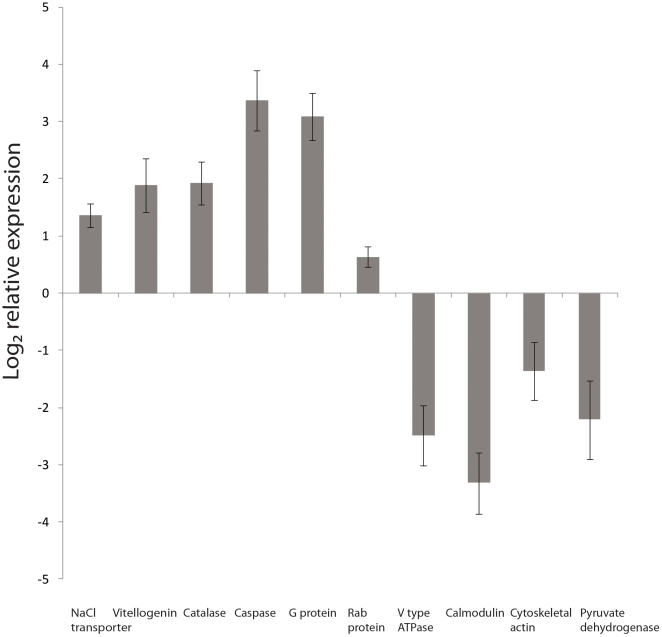
Log2 relative expression of selected genes using quantitative real-time PCR.Expression levels of genes are plotted as ratio of relative expression of high CO2 corals versus control corals at day 28. The relative expression for these selected genes was normalized to AdoHcyase and Rbl7. Bars represent standard error of the mean (n = 4).